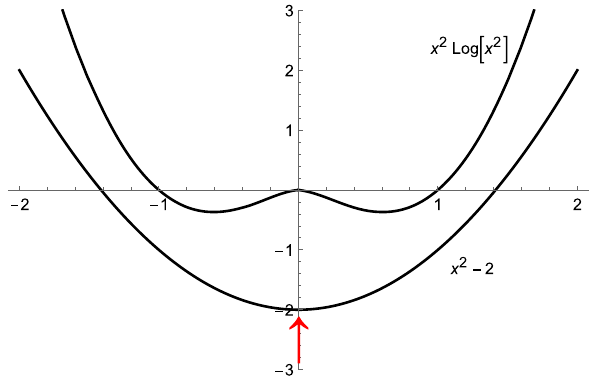
= − 2 can be 0 the parabola x 2 + N 2 is lifted 0 0